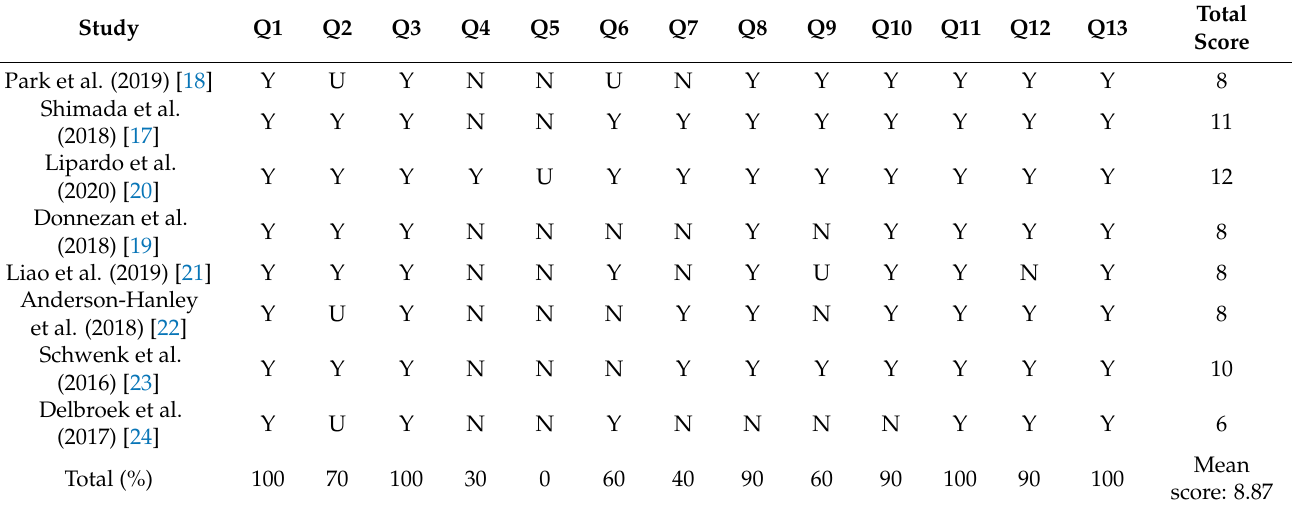
Table 2. Methodological assessment scores of included studies on the JBI Critical Appraisal Tool.